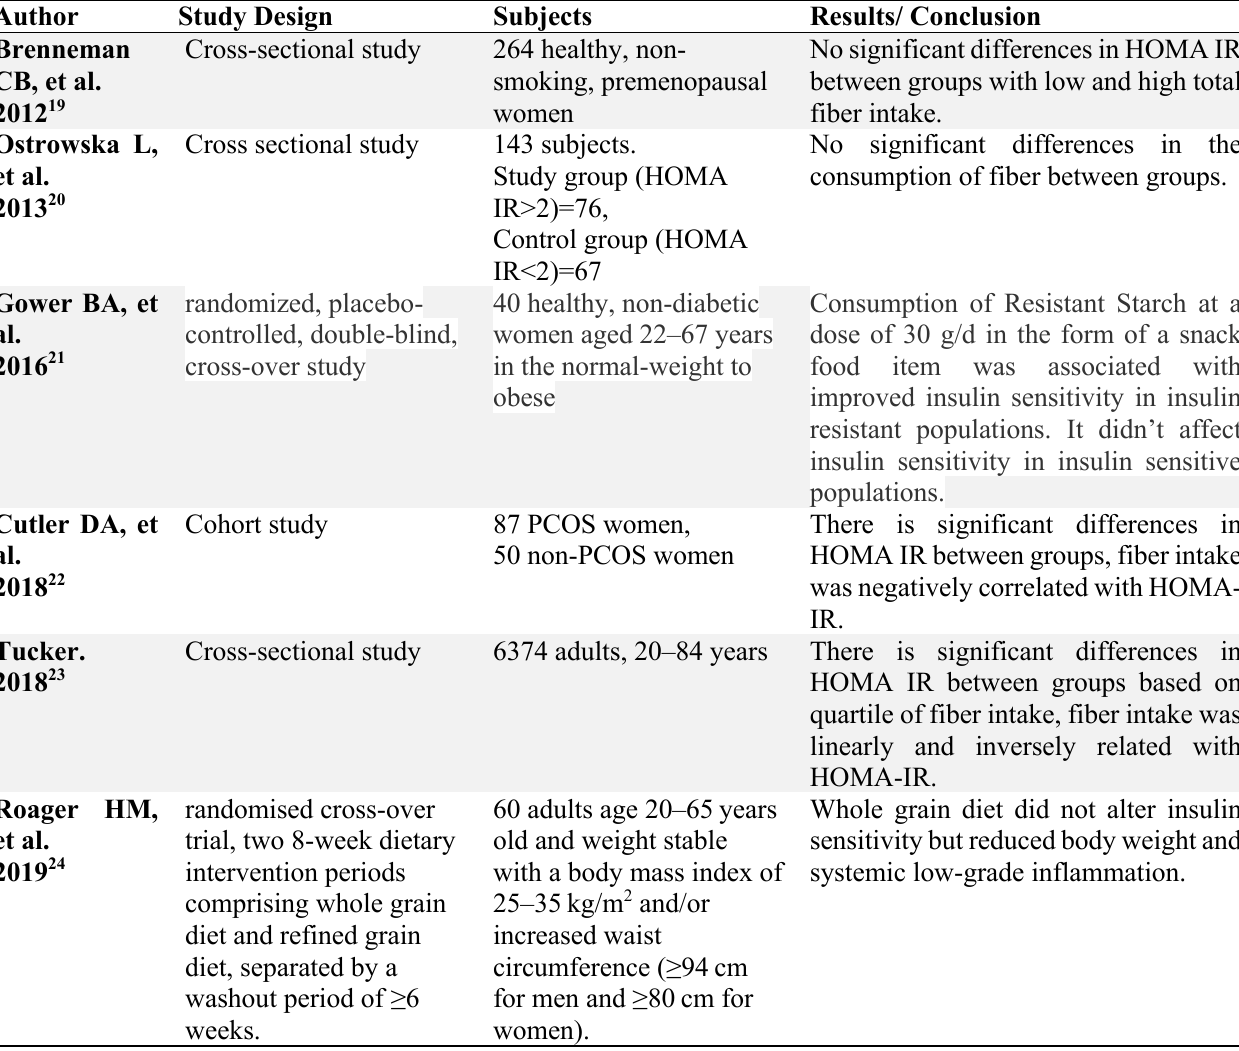
Table 1 . Characteristics of the studies that examined dietary fiber and insulin